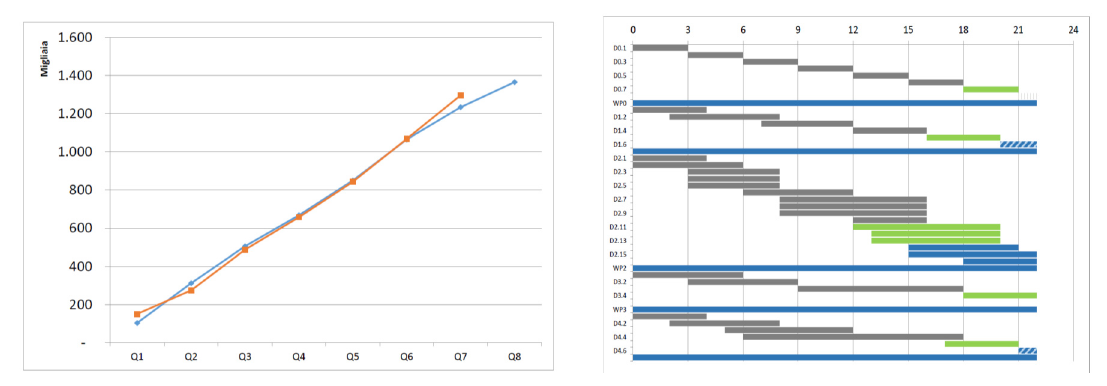
Figure 8 . High-Efficiency Vessel . Figure 8. High-E ffi ciency Vessel.